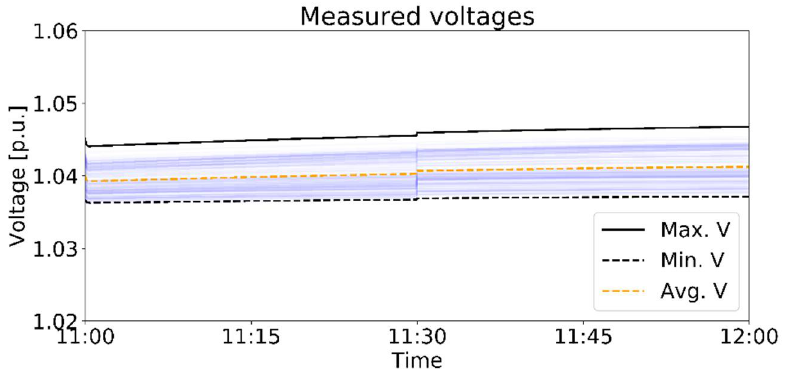
Figure 13. Results of volt/VAR control baseline scenario: average, maximal, and minimal voltage and all the voltages across the feeder.